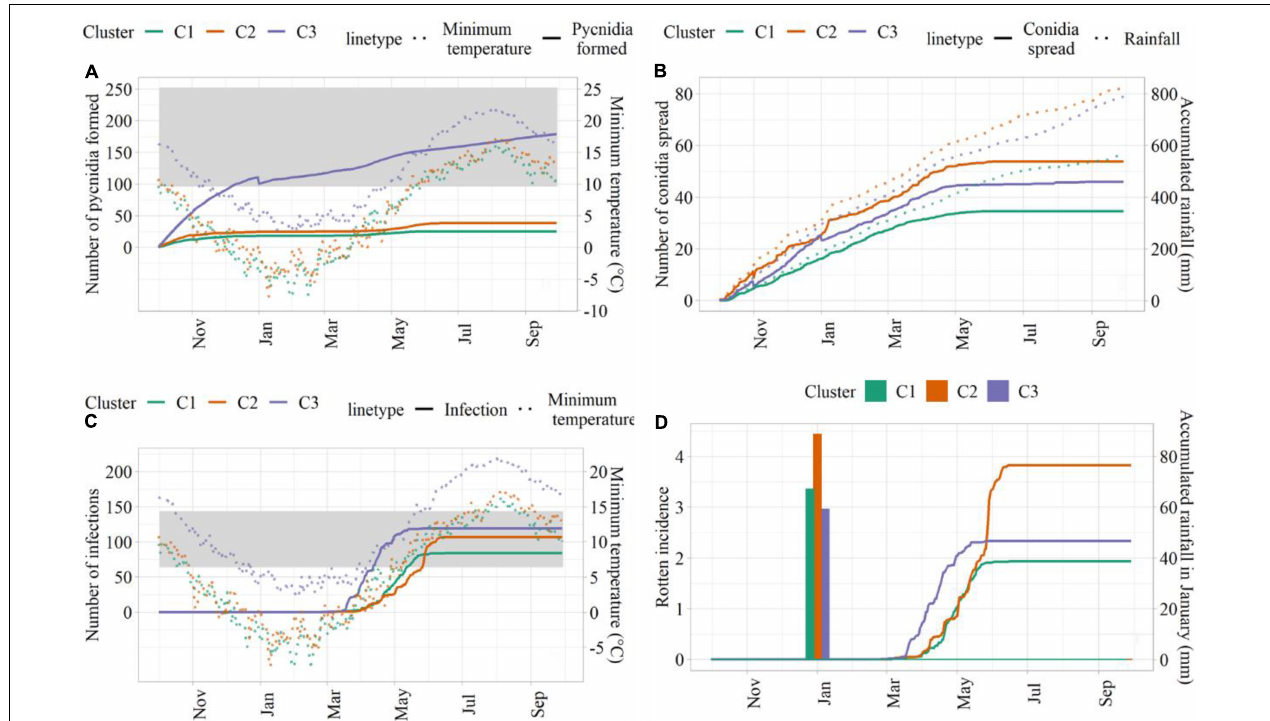
FIGURE 5 | Model outputs from sensitivity analysis. (A) Hours for pycnidia formation (solid lines) and minimum temperature ( ◦ C; dotted lines); (B) hours of conidia spread (solid lines) and cumulated rainfall (dotted lines); (C) infection hours (solid lines) and minimum temperature ( ◦ C; dotted lines); (D) simulated rotten incidence (%, solid lines) and cumulated rainfall in January (bars). The ranges of suitable temperature are indicated as shades in panels (A,C)